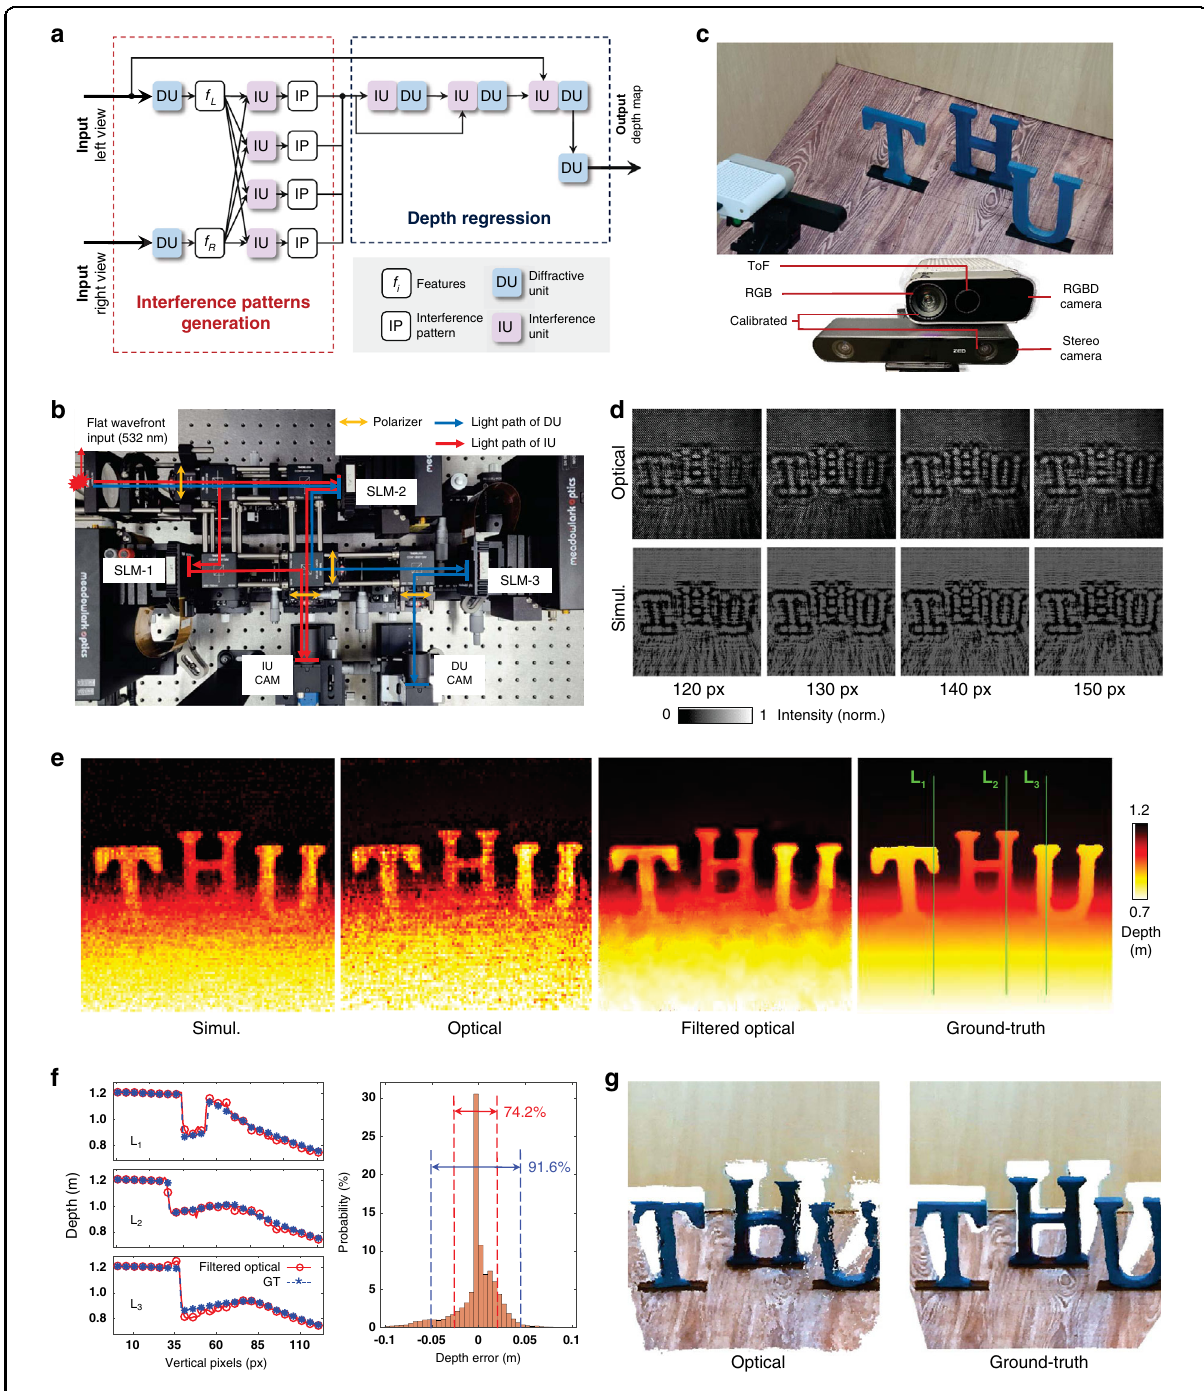
Fig. 4 Prototype system of Monet for real-world experiment. a Monet network architecture used in the prototype system implementation. b Prototype system built with off-the-shelf optical modulation devices. The red-light path denotes the IU and the blue-light path denotes the DU. c Top, a customized scene with three character-shaped objects ‘ T, H, U ’ . Bottom, the hybrid camera system for dataset capturing. d Optical and simulated interference patterns with 4 different shifts. The number below each column denotes the shift distance of the interference pattern. e Depth maps of numerical simulation, optical result (raw output of the prototype system), fi ltered optical result and the ground-truth. f Left, depth values along three lines L 1 , L 2 and L 3 on the fi ltered optical result and the ground-truth. Right, the depth-value error distribution of the whole image. g Point clouds generated from the fi ltered optical results and the ground-truth. SLM spatial light modulator, CAM camera, IU interference unit, DU diffractive unit, Simul. simulation, Px pixel, GT